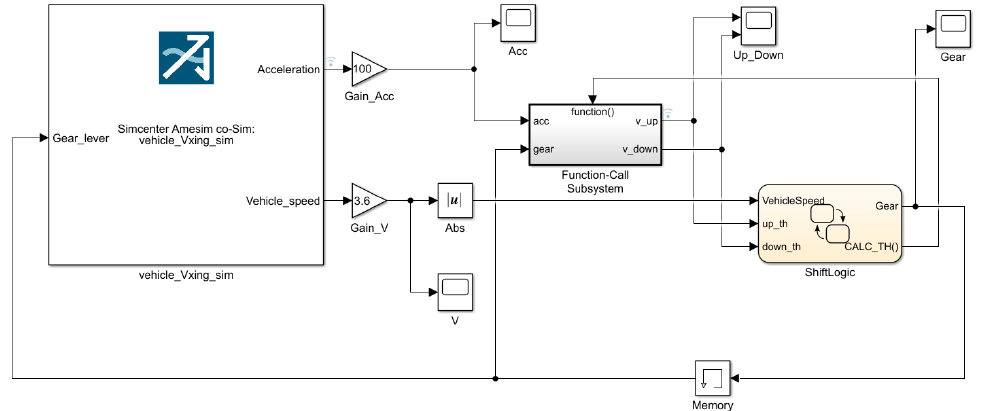
Figure 14. A Matlab/Simulink model of an automatic transmission shift rule control.